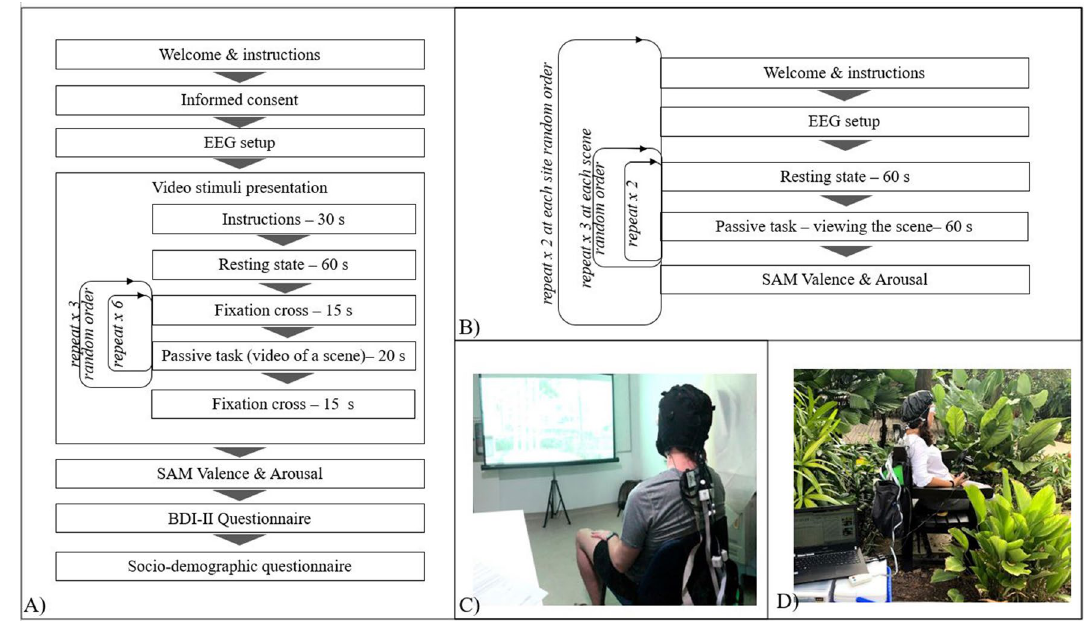
Figure 3. Experimental protocol and setup: ( A ) laboratory setting procedures, ( B ) naturalistic setting procedures, ( C ) experimental setup in the laboratory (participant during viewing of the video), ( D ) experimental setup in the park (participant during resting